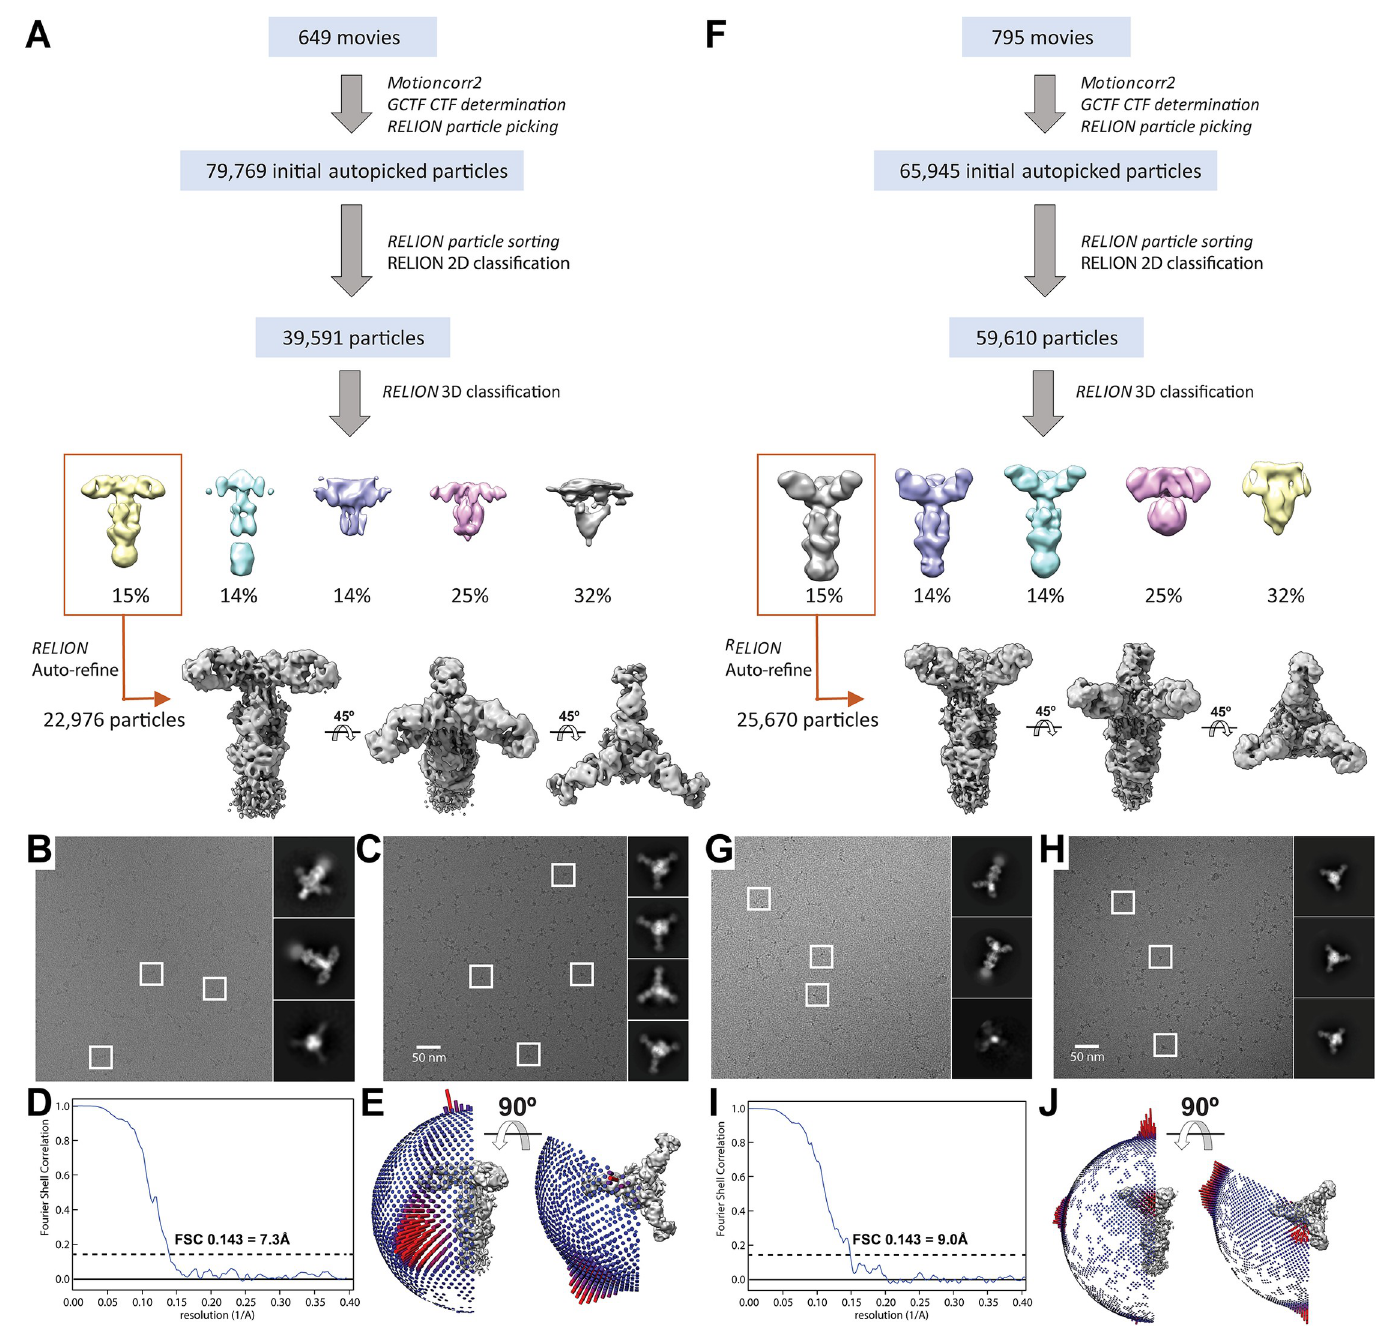
Fig 1. Classification scheme of particles identified in cryo-EM micrographs and validation of subnanometer structures of either 93k (A to E) or SG2 (F to J) Fab fragments in complex with purified VZV gB. B to J–Single particle cryo-EM micrographs of 93k (B and C) or SG2 (G and H) Fab fragments in complex with VZV gB in vitreous ice on lacey carbon (B and G) or Quantifoil (C and H) grids captured with a 200kV F20 (FEI). Representative 2D class averages are shown. Fourier shell correlation plot (D and I) and Euler angle distribution (E and J) of VZV gB-93k or gB-SG2 complex particles included in the 3D